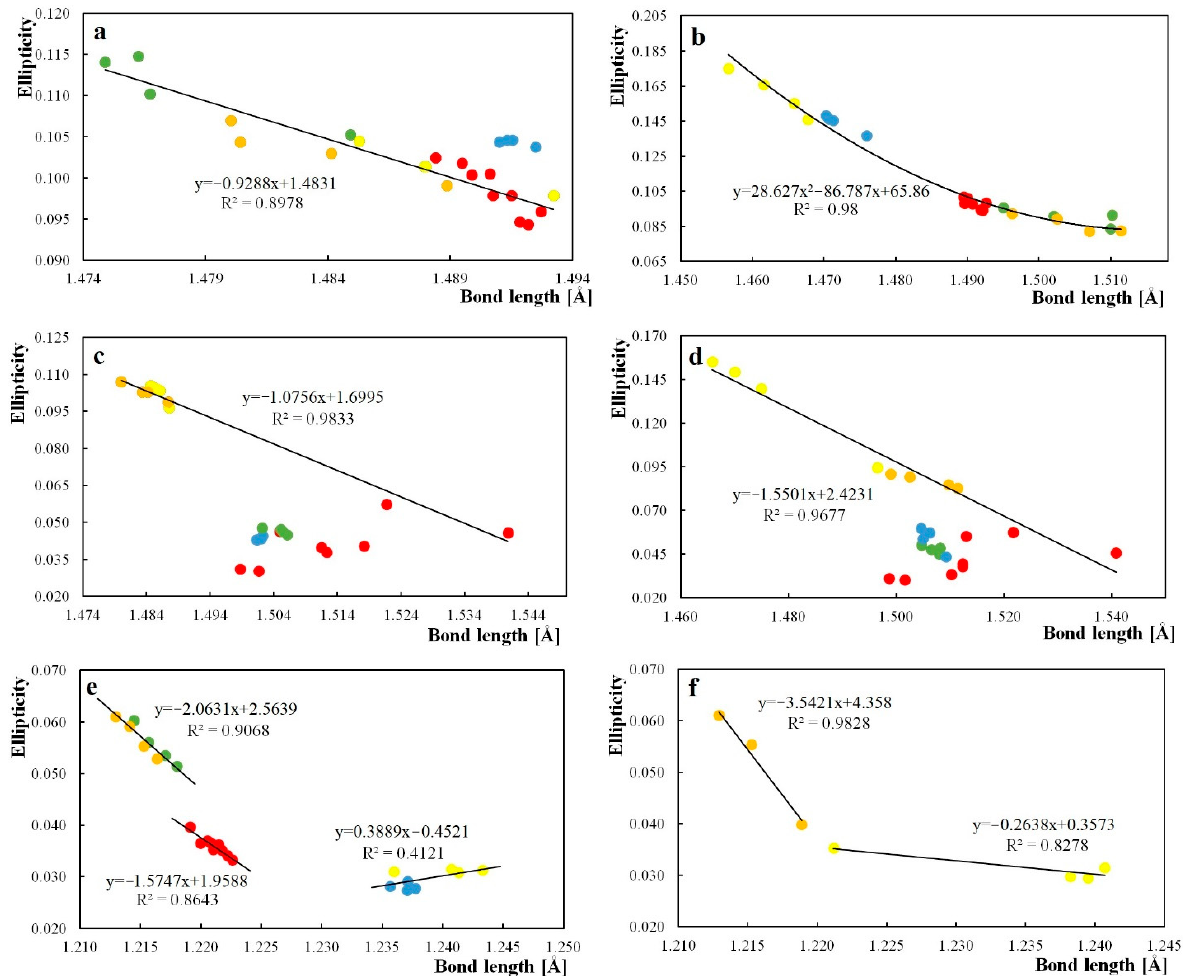
Figure 2. Correlations between ellipticity and bond length of the central aliphatic ring, ( a )—C8a–C9 bond, ( b )—C9–C9a bond, ( c )—C10a–C10 bond, ( d )—C10–C4a bond, ( e )—C9=O bond, and ( f )—C10=O bond, where red-anthrones with a substituent in the central ring, blue-anthrones with a substituent NH 2 , green-anthrones with a substituent NO 2 , yellow-anthraquinones with a substituent NH 2 , and orange-anthraquinones with a substituent NO 2 . The C8a–C9 bond for anthrones substituted with the NH 2 group in the side ring was not included in the trend line.